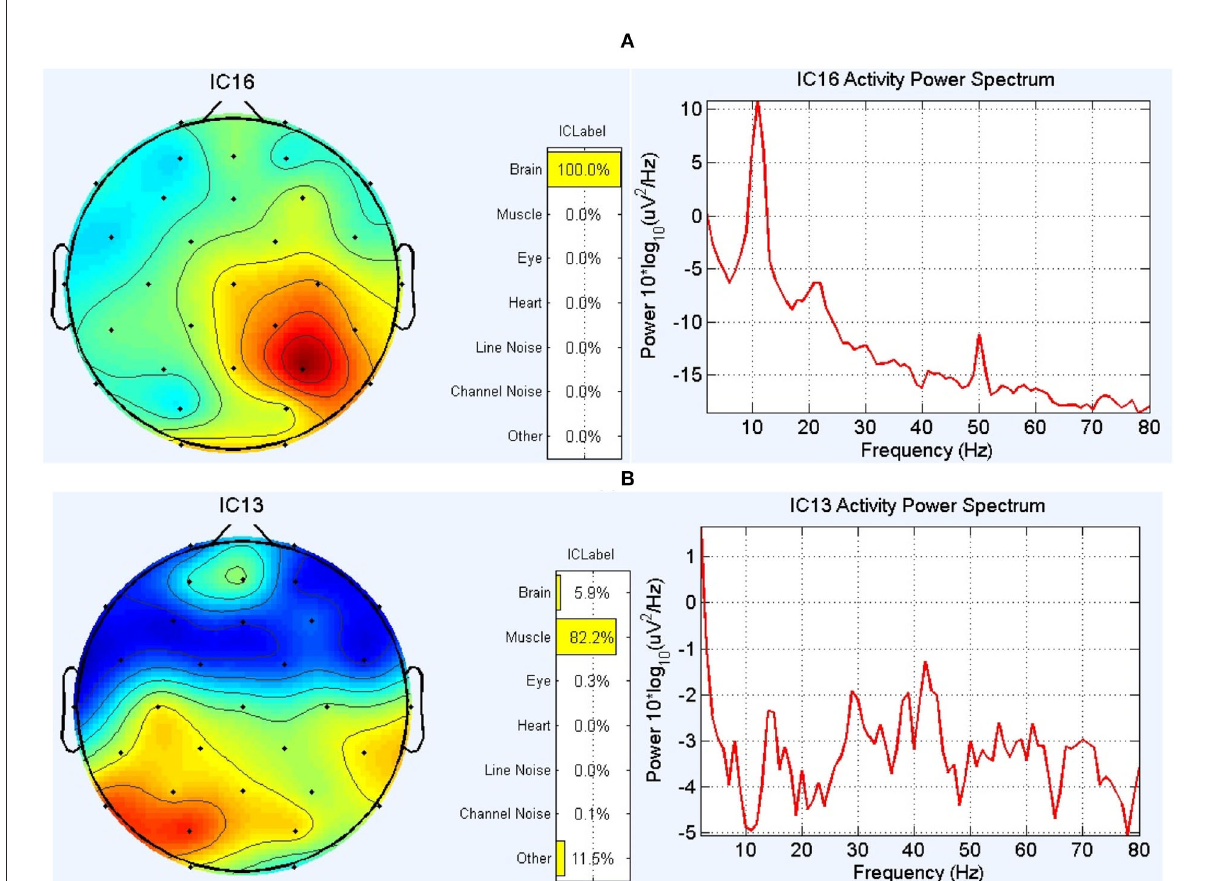
FIGURE2 The results of the ICLABLE toolbox for two components in a subject. (A) An example of the topoplot and power spectrum of a component related to the activity of the brain and therefore was included in the calculation process. (B) An example of the topoplot and power spectrum of a component that is mainly related to muscle activity (according to 1-power-spectrum activity, 2-topoplot, and 3-location of this IC in the head model) and therefore was excluded from the